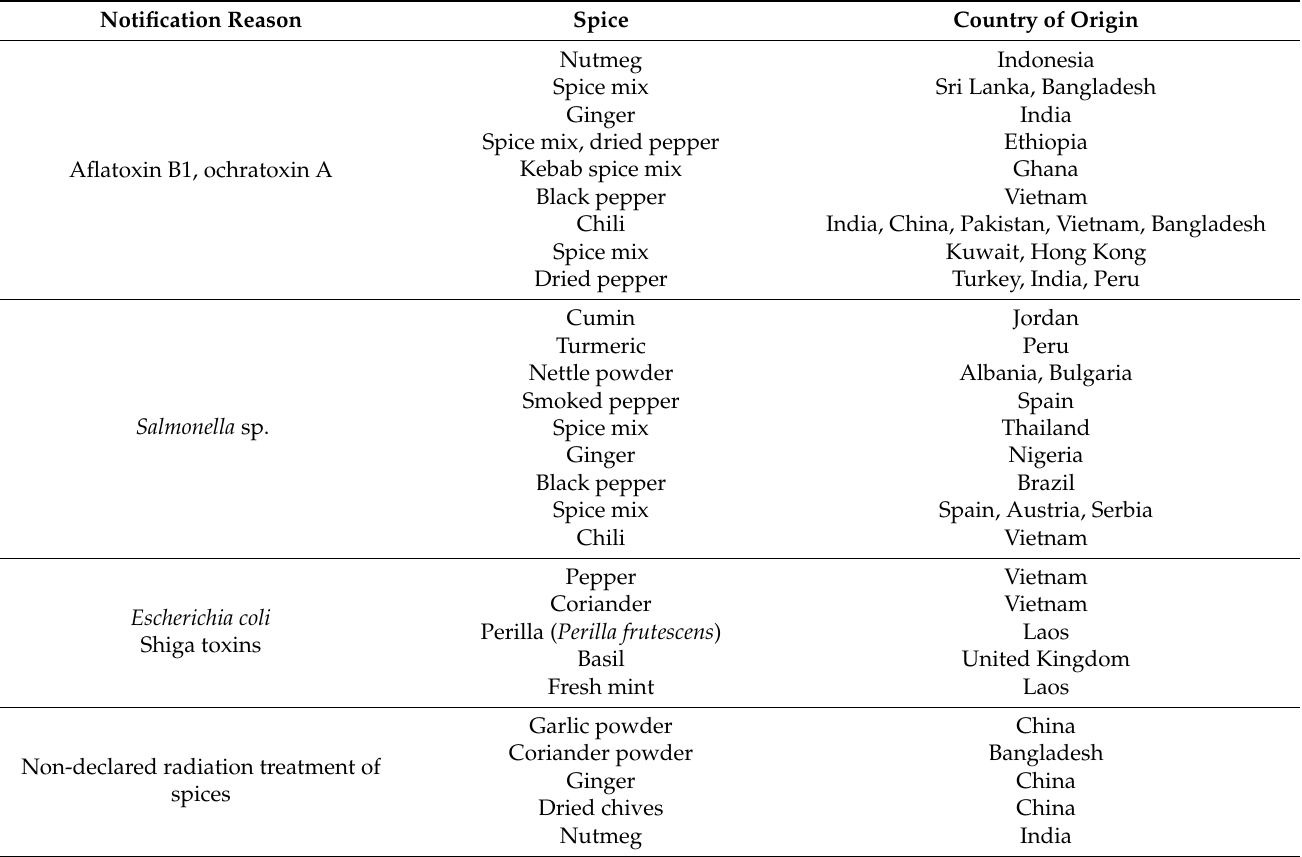
Table 2. Selected notifications about microbiological threats and radiation treatment in spices originating from different countries in 2015–2019 based on the RASFF-EC-Notifications